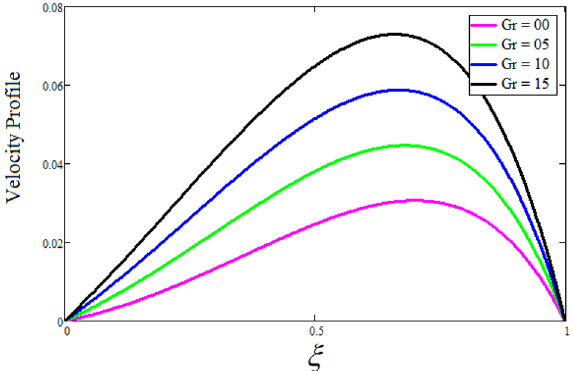
Figure 7. The consequence of Gr on the velocity distribution. Where R ζ = 2, φ = 0.04, δ = γ = π 3 , M = 5, k = 0.3, Gm = 20, β = 0.2, α = 0.5, t = 1, Sc = 10,